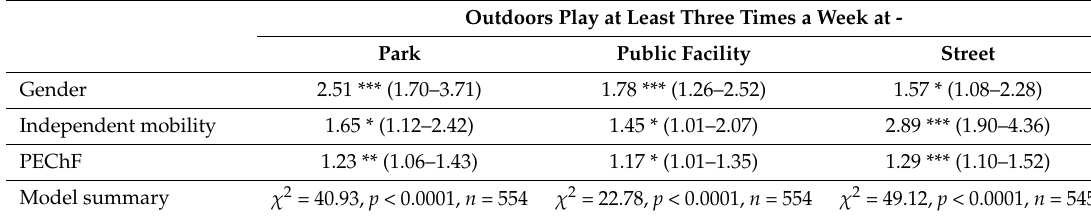
Table 3. Logistic regressions to predict OP at park, public facility and street (OR (CI)). Outdoors Play at Least Three Times a Week at -